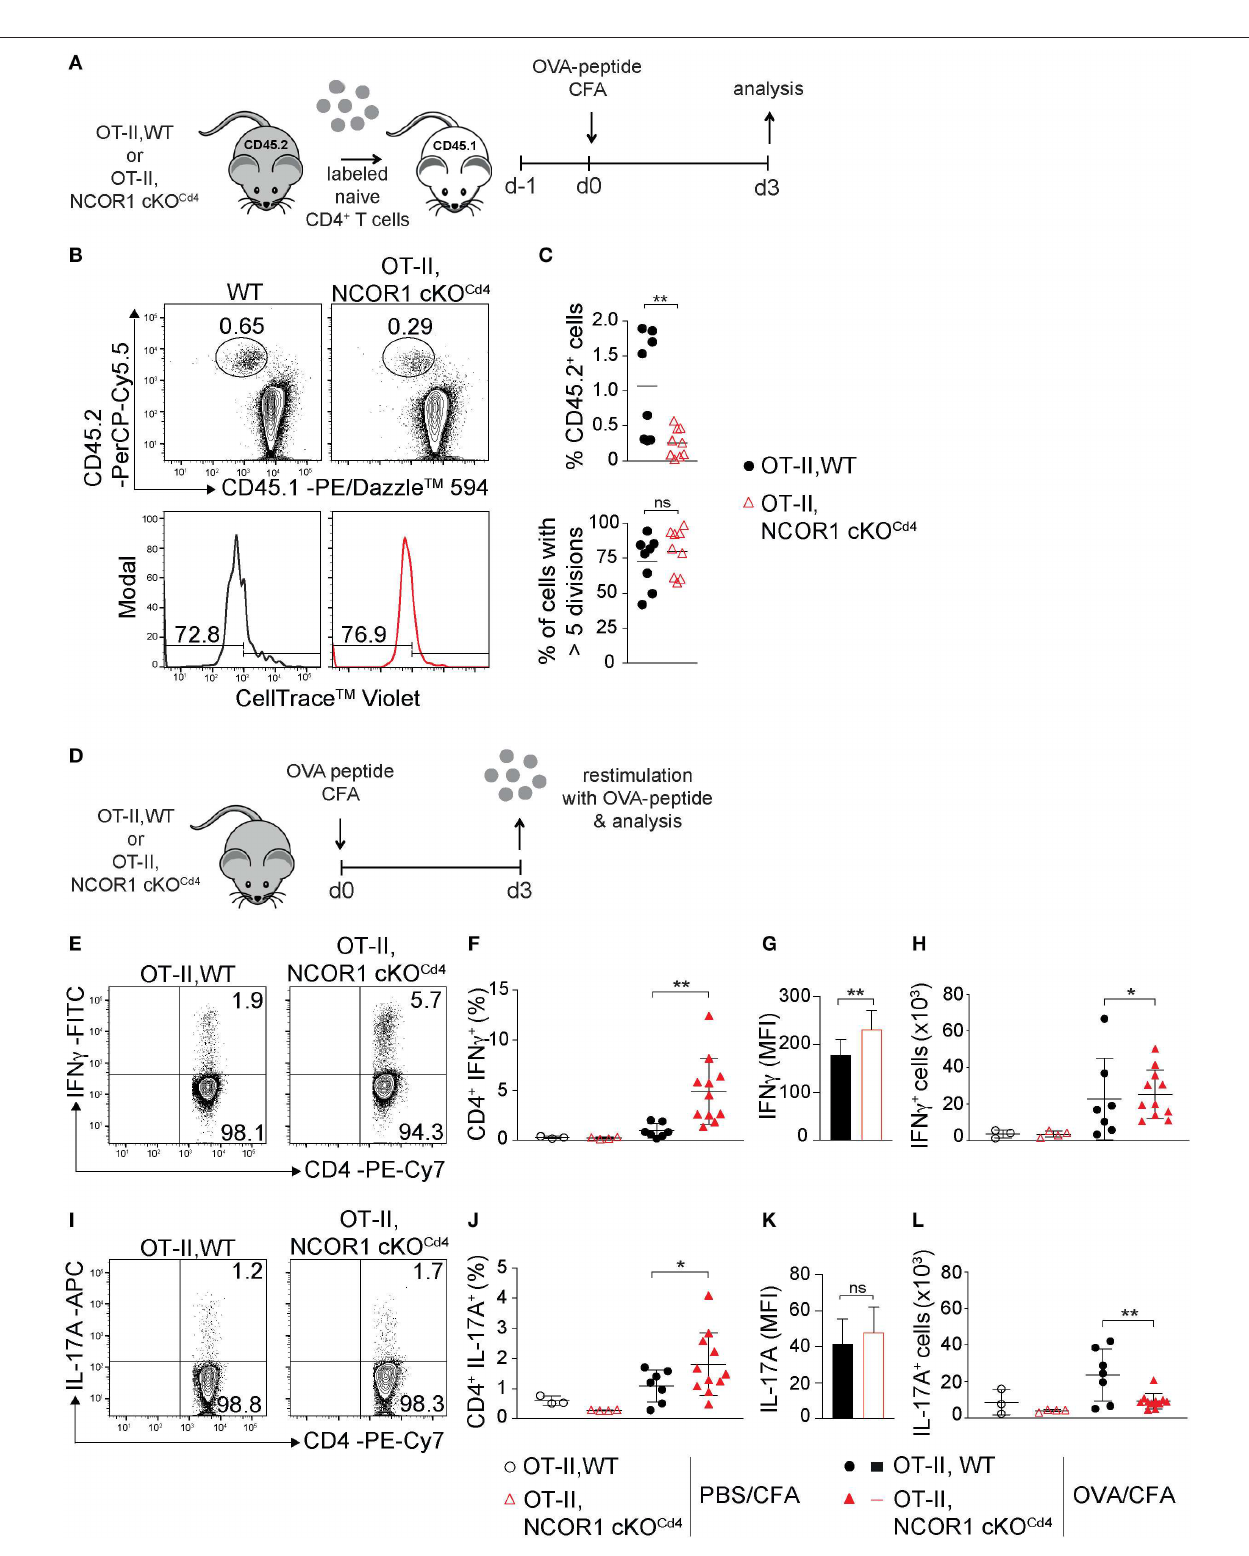
FIGURE 4 | IFN γ and IL-17A expression in NCOR1-deficient CD4 + T cells is increased upon in vivo short-term activation. (A) Experimental set up: Naïve OT-II,WT or OT-II,NCOR1 cKO Cd4 CD4 + T cells (CD45.2 + ) were labeled with cell tracker dye and transferred into CD45.1 + recipient mice (day − 1). Mice were immunized s.c. with OVA-peptide/CFA (day 0) and draining lymph node (dLN) cells were analyzed on day 3. (B) Contour plots (upper panel) show CD45.1 + CD45.2 −